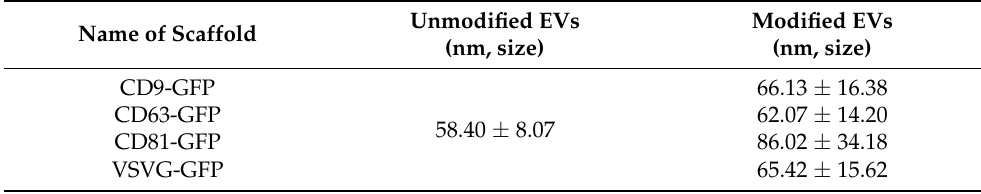
Table 2. Effects on the size of EVs via transmembrane scaffold.